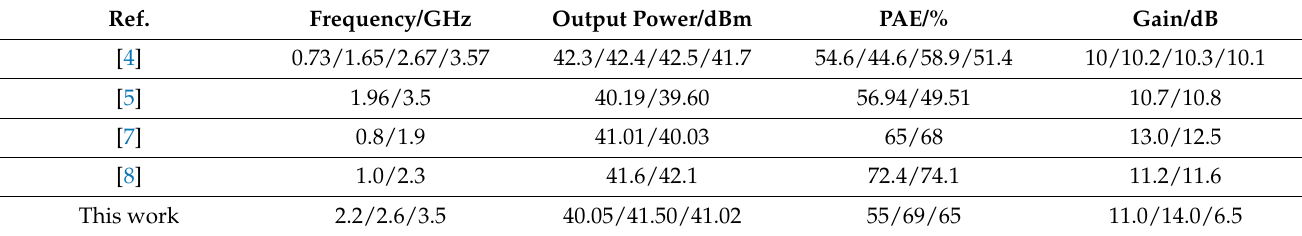
Table 2. Performance comparison of same type power